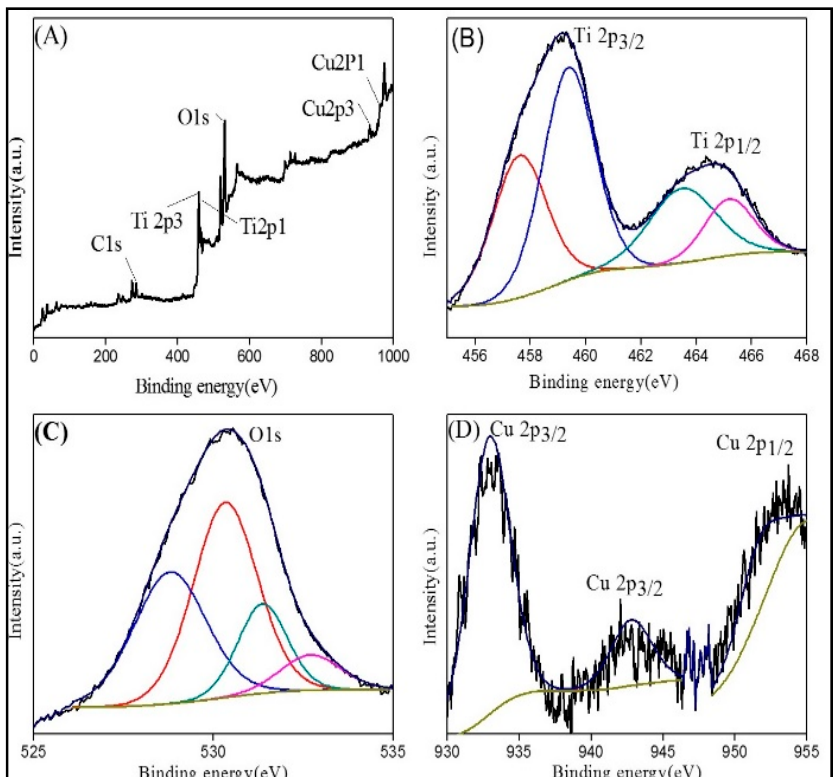
Figure 4. XPS spectra for G-2. ( A ) High resolution spectra, ( B ) resolution spectra for Ti, ( C ) resolution spectra for O, and ( D )resolution spectra for